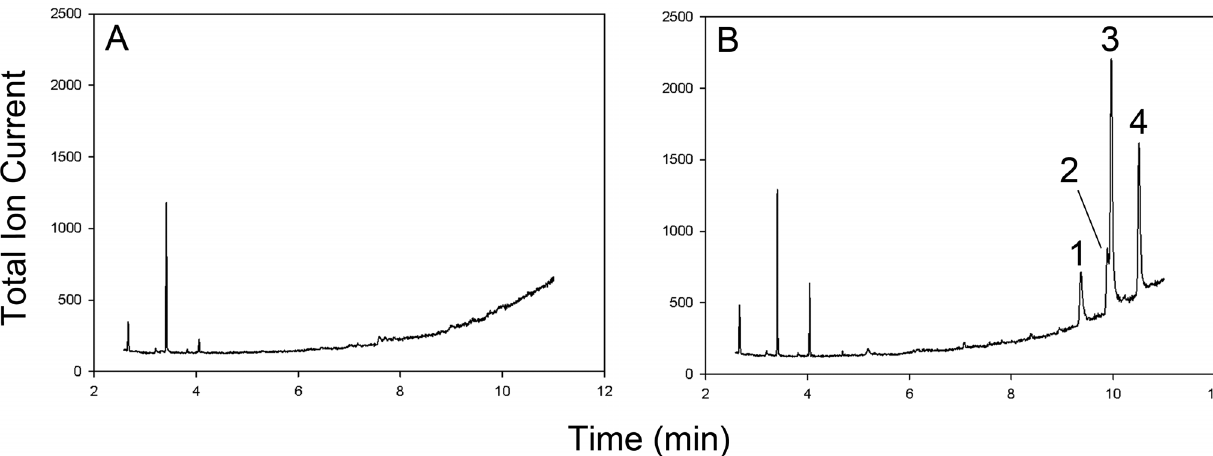
Figure 5. Selected ion (m/z 165 and 235) chromatograms for field control hut (A) and treatment hut (B). 4, 4 9 DDE (peak 1), 4, 4 9 DDD (peak 2), and 2, 4 9 DDT (peak 3) were detected with the target analyte 4, 4 9 DDT (peak 4). Peak identity was confirmed by retention time and mass spectral data from analytical standards.